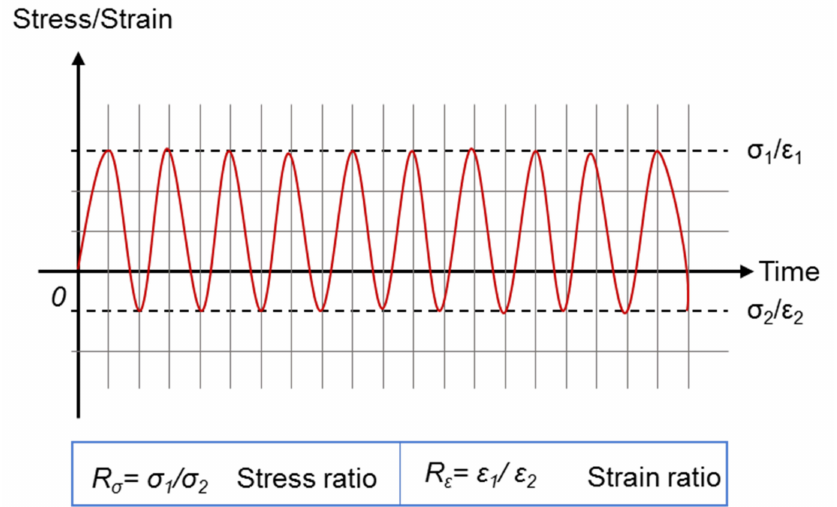
Figure 8. Definition of stress–strain